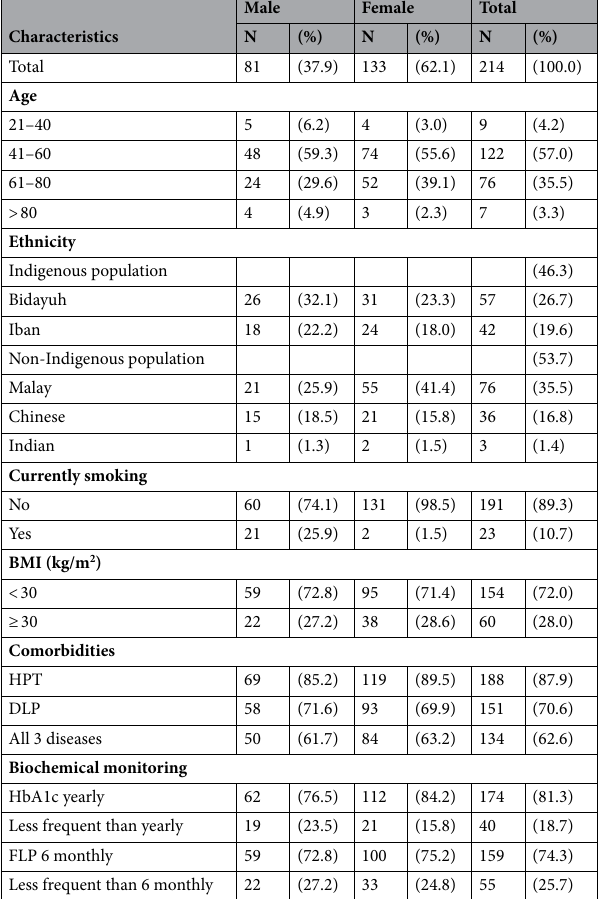
Table 1. Sociodemographic characteristics of patients (N = 214).